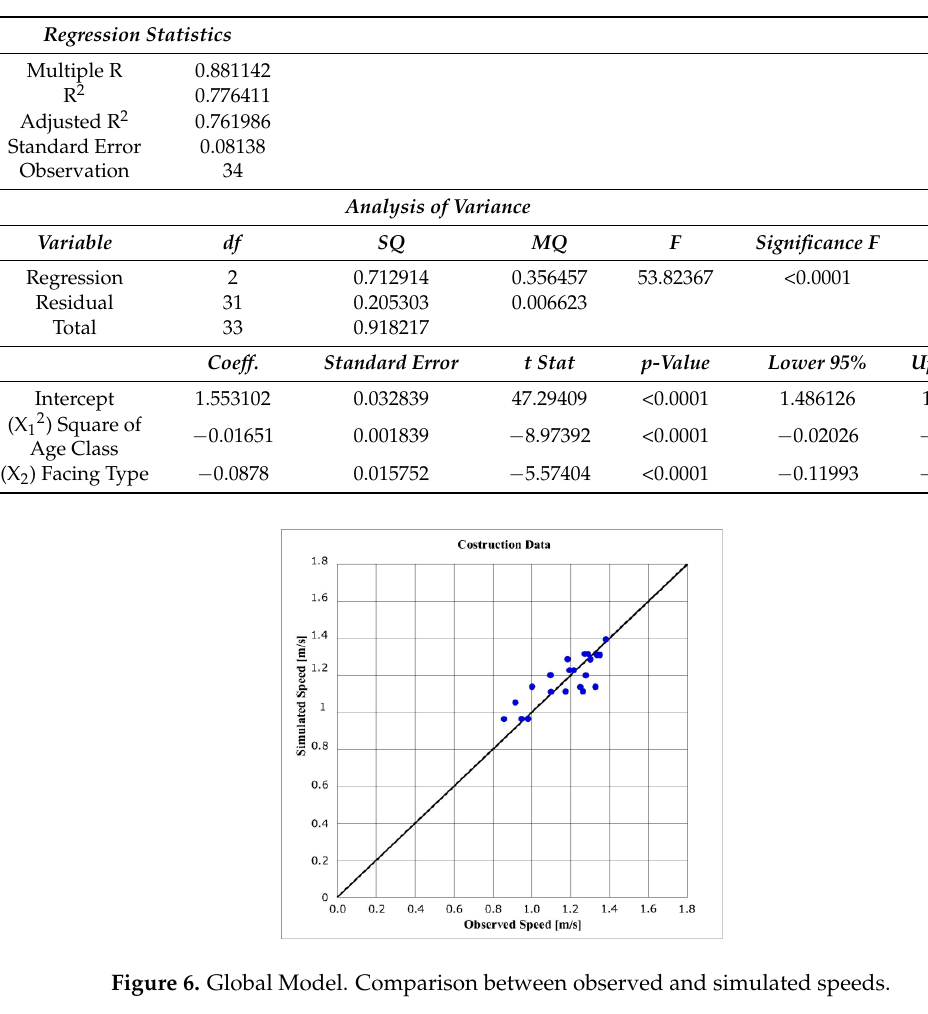
Table 4. Global model: regression statistics and ANOVA.